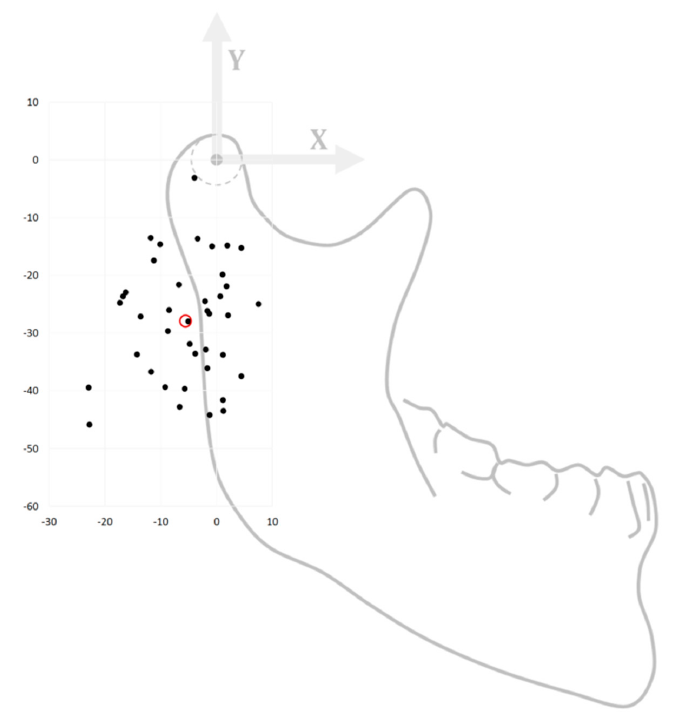
Figure 5. A scatter plot showing the 40 patient-specific centres of rotation coordinates we determined for our cohort (left & right sides). They are overlaid onto a generic mandible for reference, where the (0, 0) point lies in the centre of condyle point (CoC). The red circle indicates the mean measurement, ( − 5.7, − 28.3). Table 1. All the calculated centre of rotation (CR) positions per subject and per laterality. The delta-Y and delta-X columns show the distance from the patient’s specific centre of condyle (CoC) point, which lies in (0, 0). A negative delta-Y value indicates a shift inferiorly of the CoC and a negative delta-X value indicates a shift in the posterior direction. Right CR Left CR Patient Sex